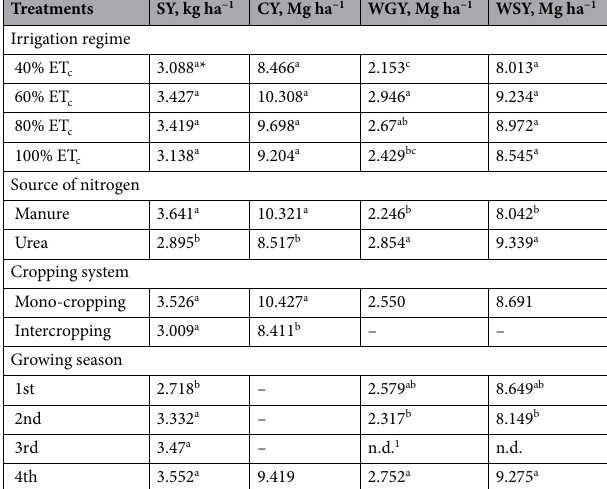
Table 1. Means for saffron (dried stigmas and styles), corm, wheat grain and wheat straw yields (SY, CY, WGY and WSY, respectively. *Means followed by similar letters in each column for each factor and each trait are not significantly different at 5% level of probability according to Tukey test. n.d. not